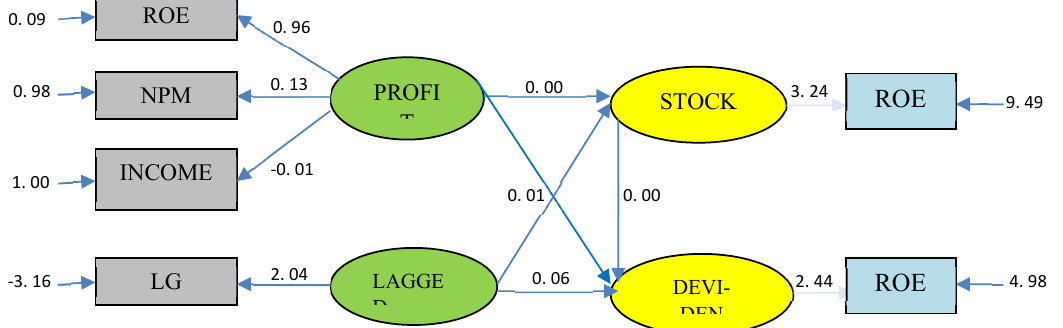
Fig. 2 explains the values of the relationship between the Profit - Stock Exchange variables: 0.00; Profit - Dividend: 0.01; Lagged - Stock: 0.01; Lagged - Dividend: 0.06; and Stocks - Dividend: 0.00. The values of each covariance of the